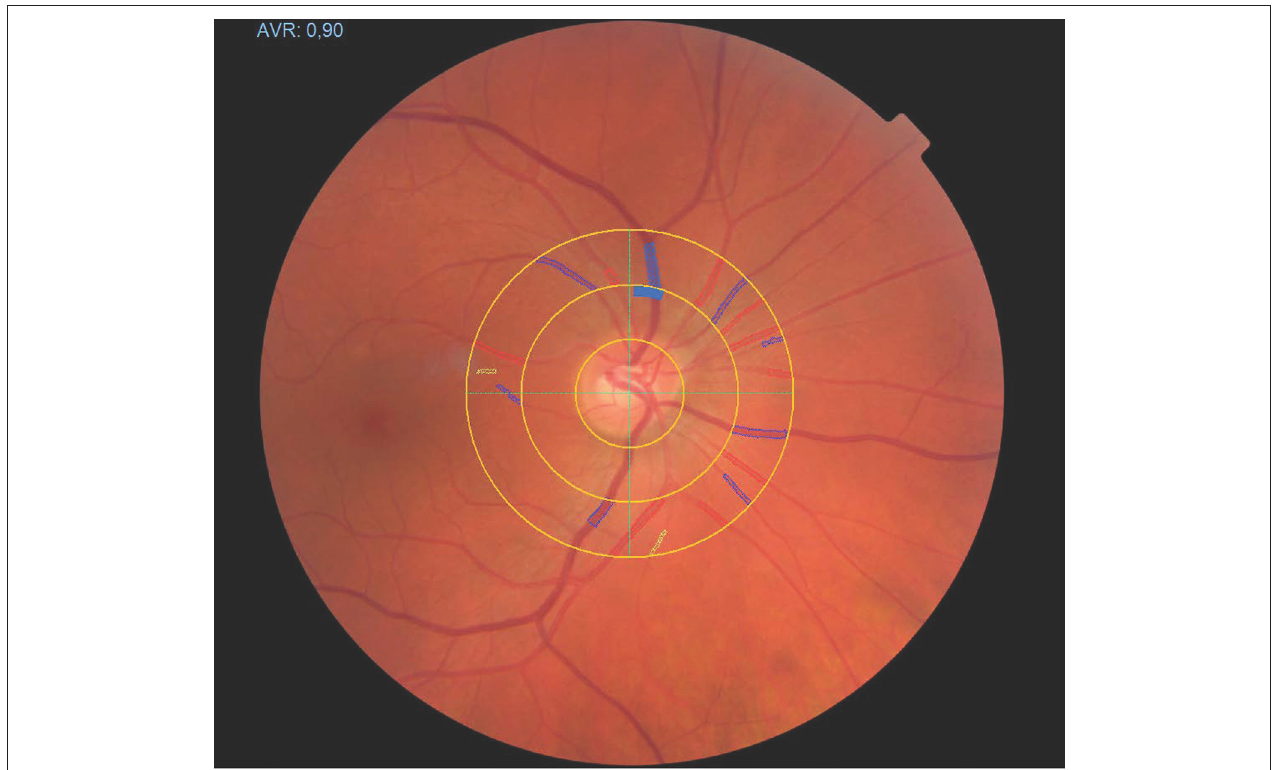
FIGURE 1 | Fundoscopy of the human retina. A software-based identification of retinal vessels in ring-zones allows for measuring of arteriolar and venular